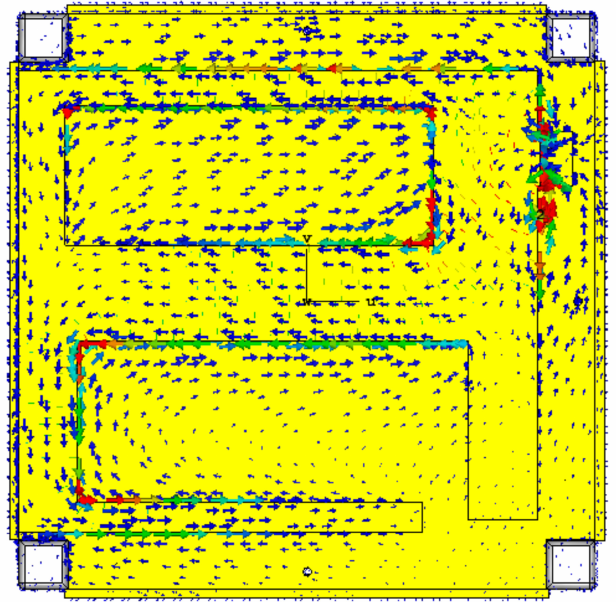
Figure 5. Surface current distribution of the planner inverted F antenna (PIFA) antenna at 450 MHz; starting from the feed point, the travelling current forms a larger electrical path to achieve resonance at a lower